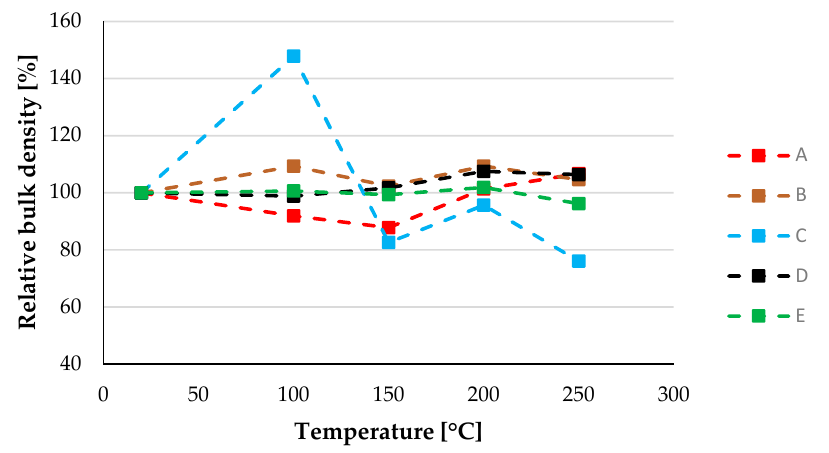
Figure 3. Bulk density (%) vs. exposure temperature. Table 2. Bulk density average vs. exposure temperature. Bulk density [kg/m 3 ] (standard deviation)